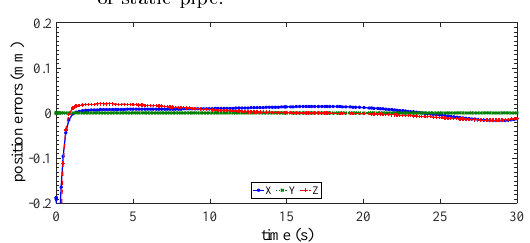
Fig. 13: Position errors of the end-e(cid:27)ector in the case of static pipe.